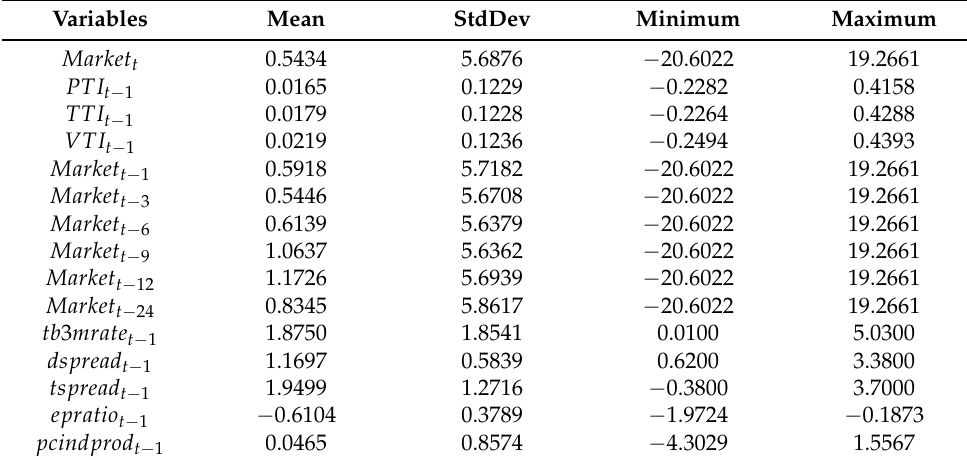
Table 1. Descriptive